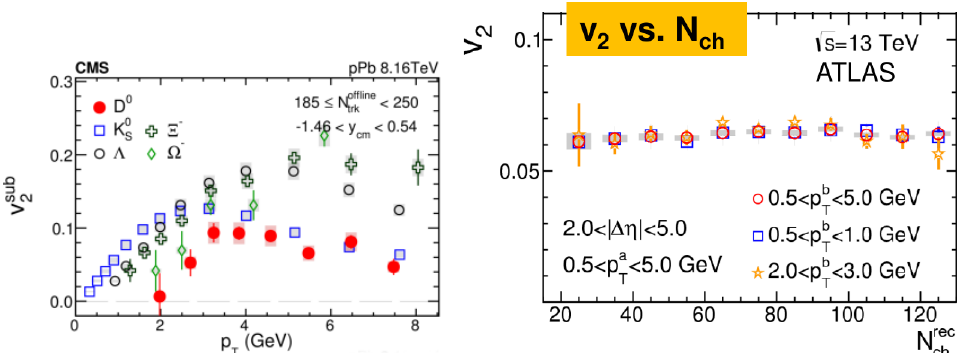
Figure 13. Left : v 2 flow as a function of p T of charm and strange hadrons in high-multiplicity pPb √ s NN = 8.16 TeV (CMS Collaboration [35]); Right : v 2 as a function of p T in pp collisions collisions at √ s = 13 TeV (ATLAS Collaboration [36].) at